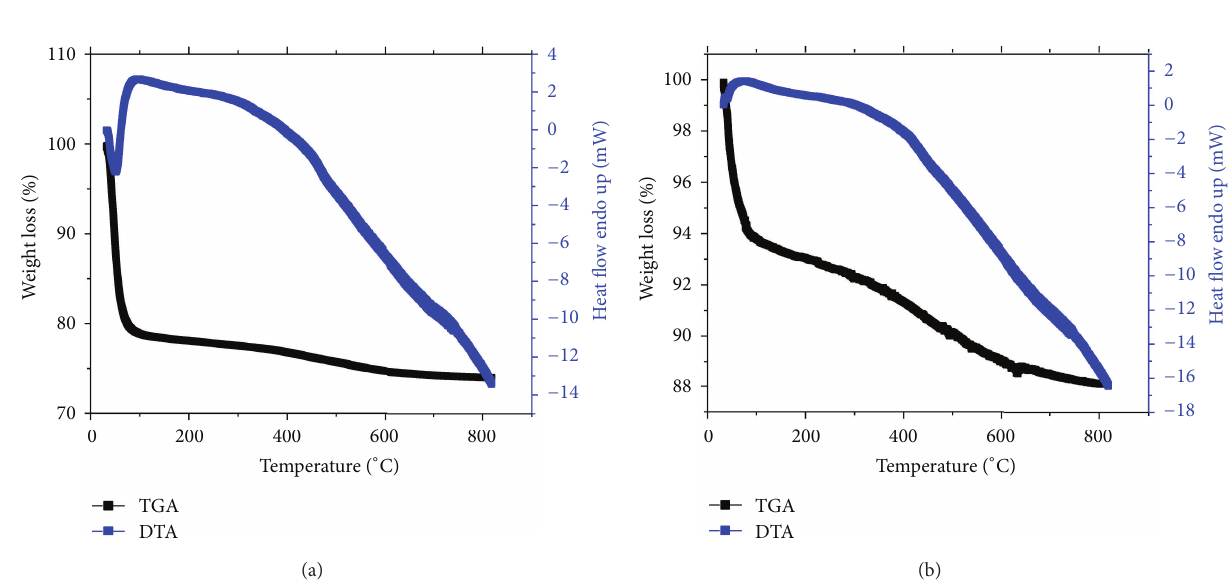
Figure 10: TGA/DTA curves for MMT NP used in (a) UMMT and (b) RMMT.